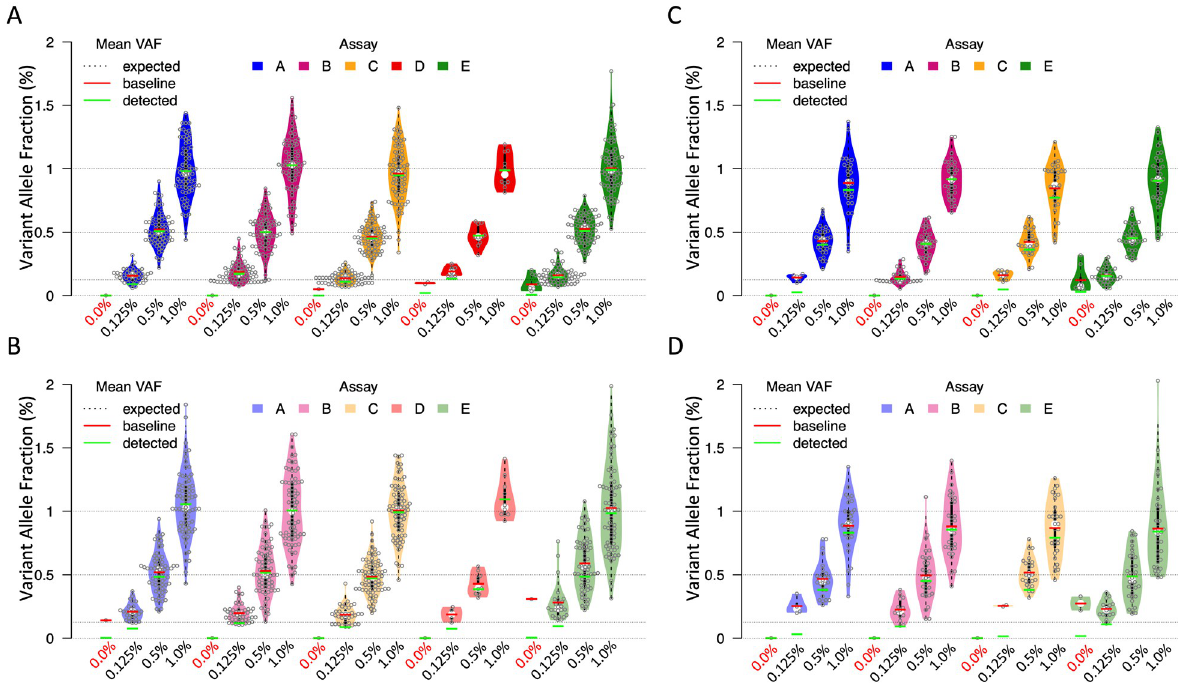
Fig 3. Quantification and accuracy of average VAF. Average VAF (green dash) was calculated using individual reported VAFs of all the reference mutations including 0% VAF values of non-detected mutations. The average VAF of only detected mutations (red dash) was also included for information purpose; the expected VAF is represented at 0%, 0.125%, 0.5% and 1% (dotted horizontal line). A, Distribution of the observed VAFs of the reference mutations in sample set one at 0 to 1% VAF and input of 30 ng (assay A and B) or 50 ng DNA (assay C, D, E); false positive mutations were detected by assay D (red) and assay E (green) from negative samples (violin plots at 0% VAF). B, Similar analysis for sample set one with 10 ng DNA input; average of observed VAFs was consistent with expected values for all five assays. False positive mutations were detected by assay A (light blue) and assay E (light green) from negative samples. C, Similar analysis for sample set two with 30 ng (assay A and B) or 50 ng (assay C, D, E) DNA input; average VAFs of assay B and assay E were closer to the expected values. Assay E (green) detected false positive mutations in negative samples. D, Similar analysis for sample set two with 10 ng DNA input; average VAFs of assay B and assay E were closer to the expected values. Assay E (green) detected false positive mutations in negative